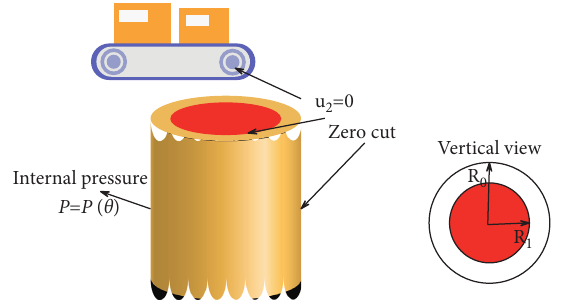
Figure 3: Internal pressurization of supply chain transportation